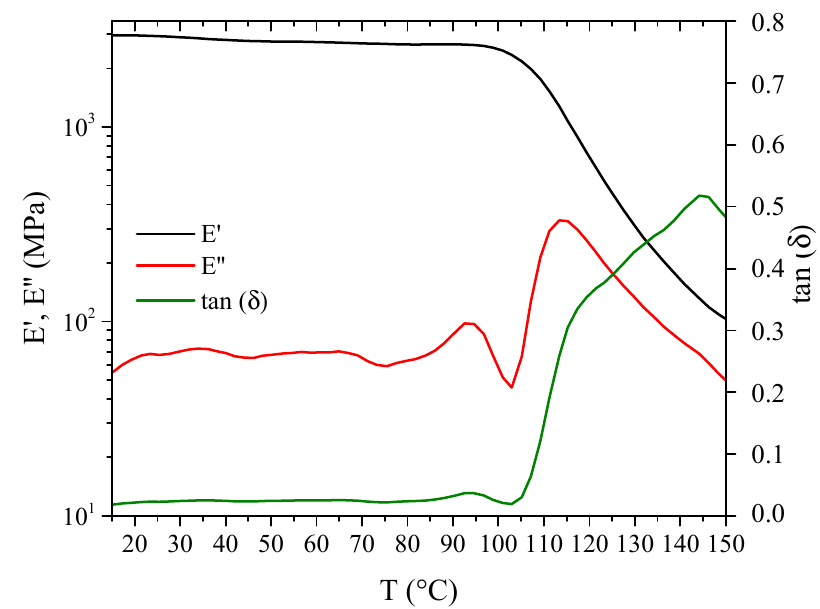
Figure 6. Storage modulus E’, loss modulus E” and damping factor tan δ from Dynamic mechanical thermal analysis (DMTA) of M22 DA polymer reinforced with nonwoven mat.